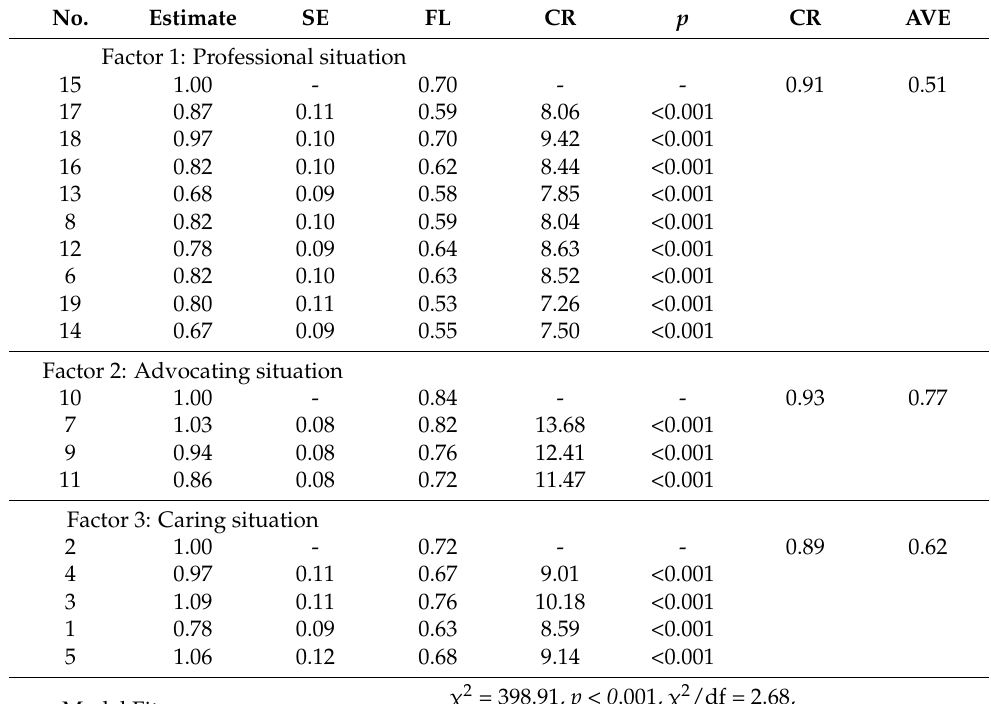
Table 2. Confirmatory Factor Analysis of K-NPSE (N = 218).